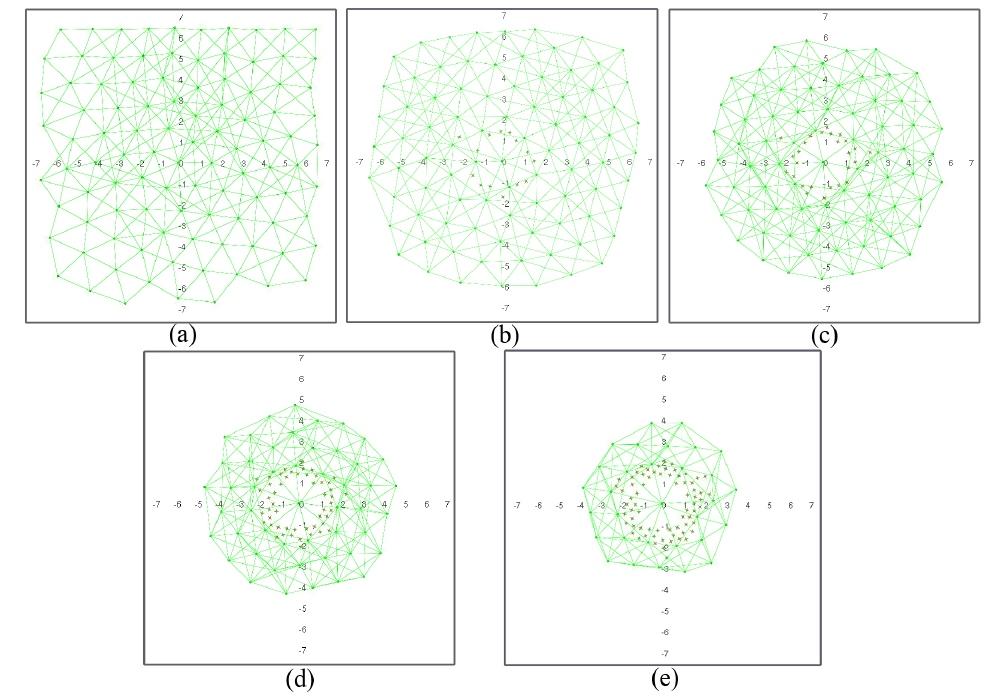
Figure 7. Network configuration when: ( a ) 0%; ( b ) 12.5%; ( c ) 25%; ( d ) 50% and ( e ) 70% of the nodes are dead (figures are scaled 1:10